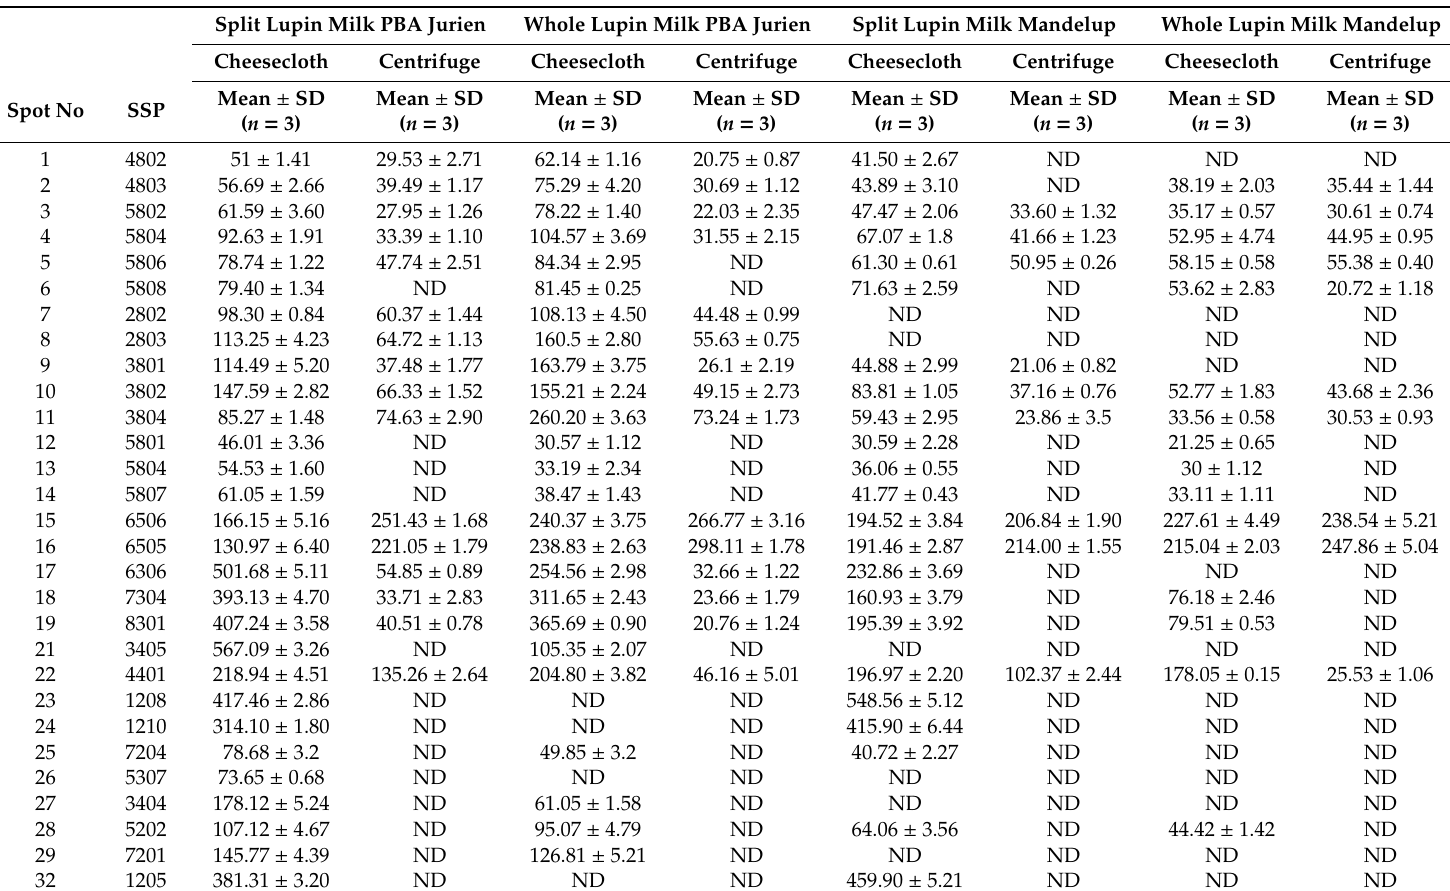
Table 2. Quantitative list of each identified protein spot with respect to extractability in the lupin milk made from di ff erent samples types, separation technique and the cultivar. The spots are significantly di ff erent ( p < 0.05) at PDQuest